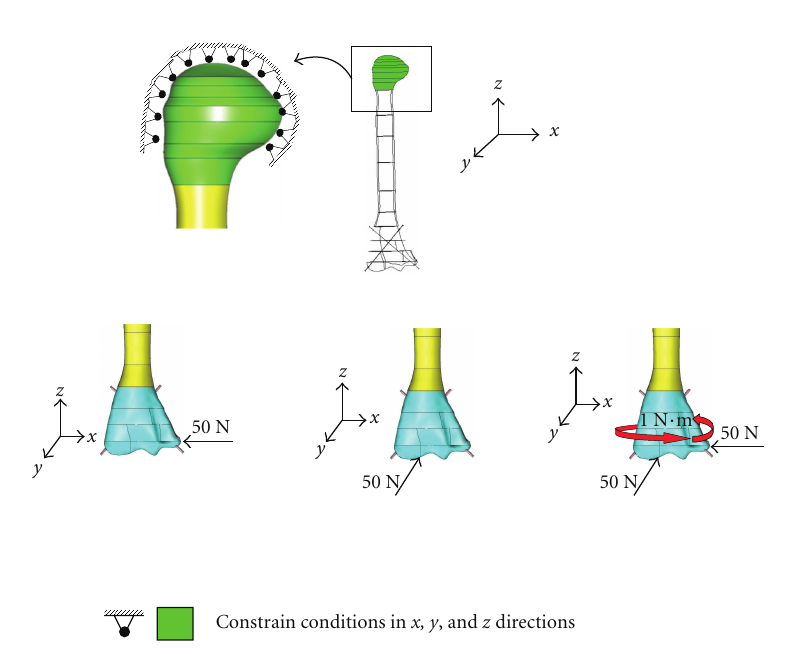
Figure 6: Assigned constrain and loading conditions on the developed solid models.